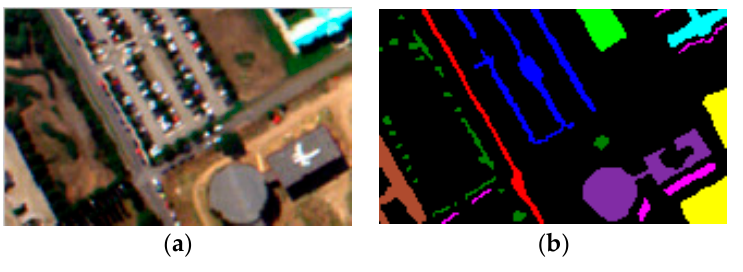
Figure 7. ( a ) Part-PaviaU HSI. ( b ) Ground truth.